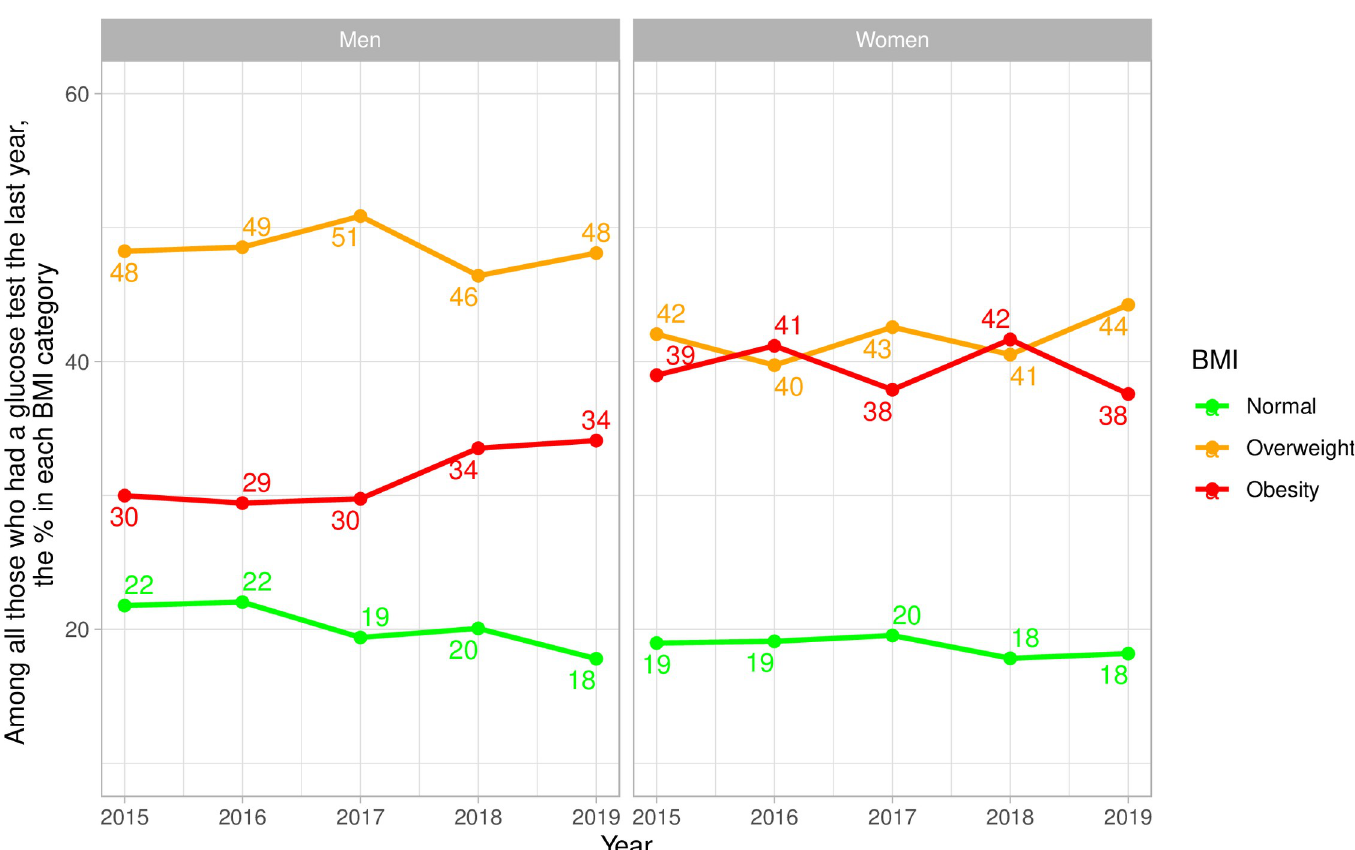
Fig 1. National time trends of glucose test by body mass index categories stratified by